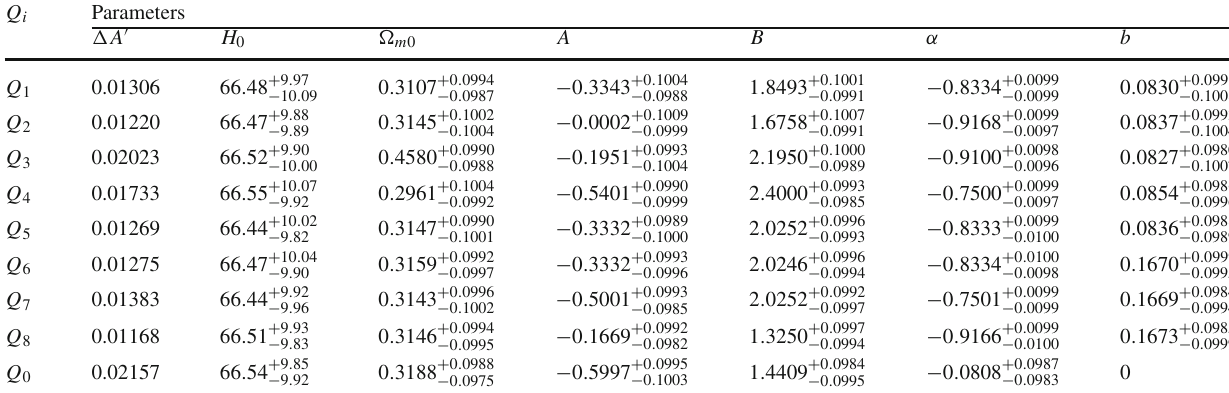
Table 2 The optimal values for the model free parameters A , B , α , b , H 0 and (cid:13) m 0 for each dark energy–dark matter interacting model. We remind that the equation of state we are adopting for the dark energy is p = A ρ de − B ρ α , and that b quantifies the strength of interaction de between dark energy and dark matter according to the modelings (12),